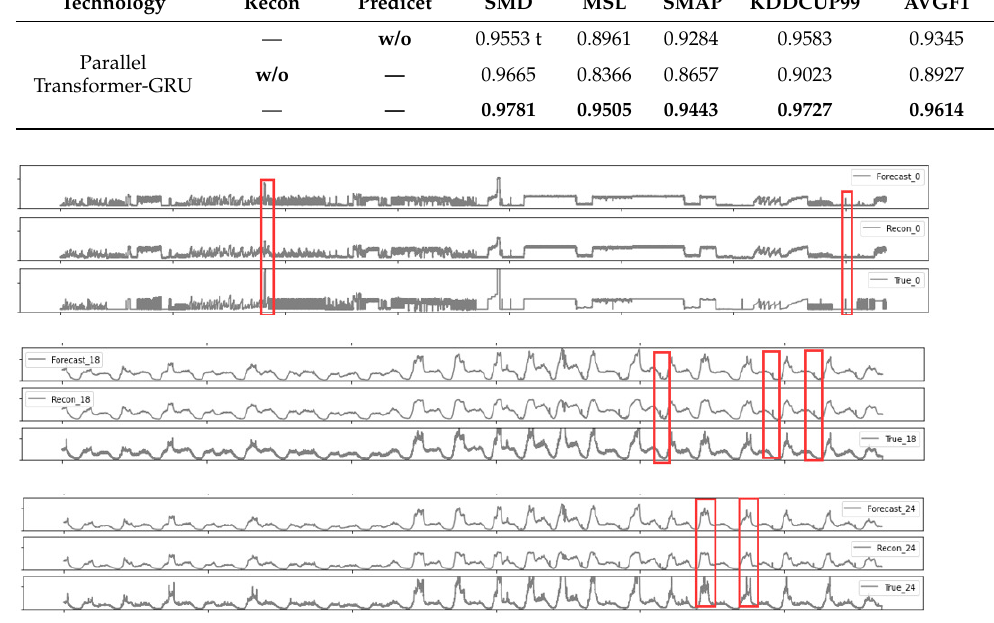
Figure 6. Periodic changes of test set